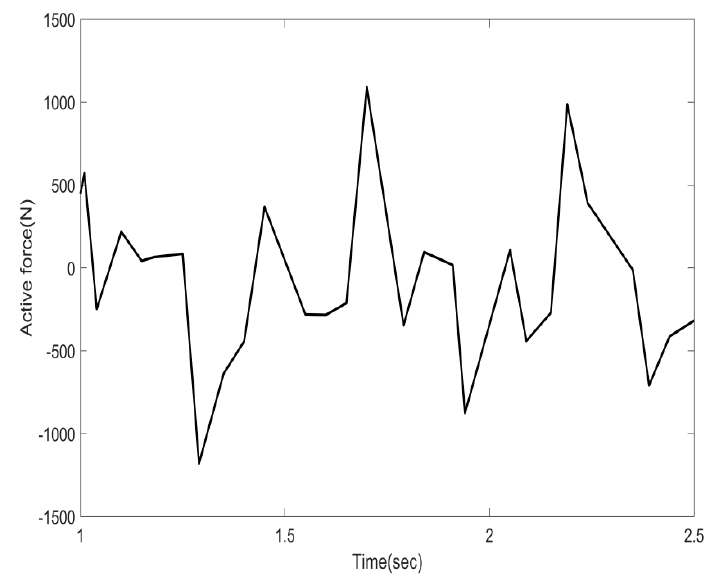
Figure 7. Control forces for a non-linear semi-active hybrid isolator using a sliding mode control (SMC) [34].